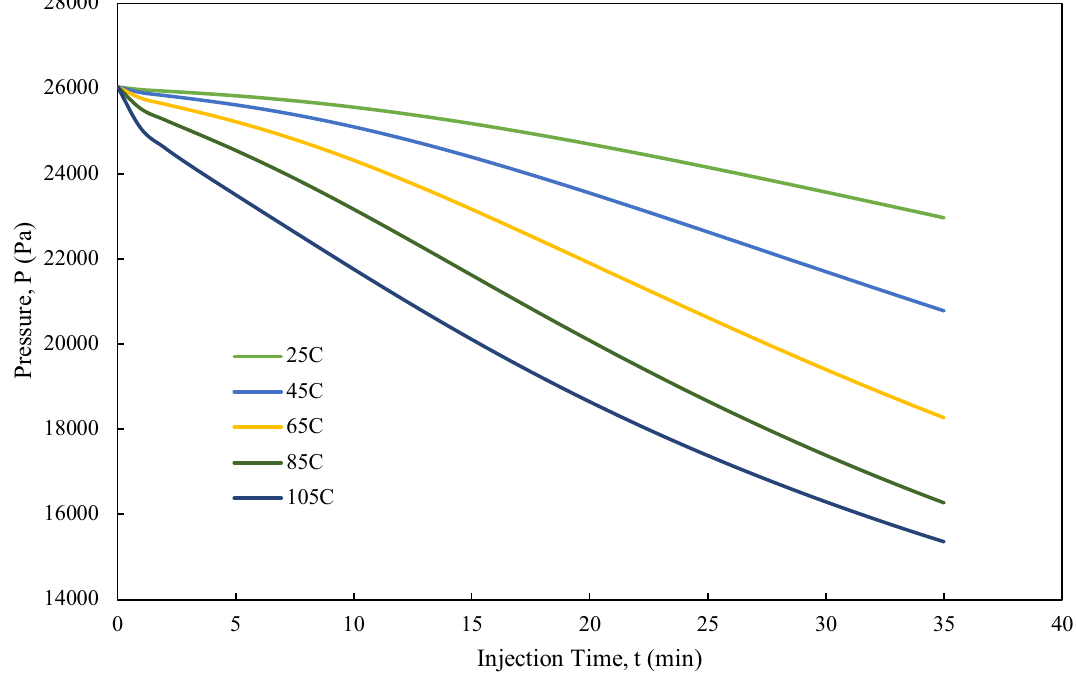
Fig. 10 The effect of temperatures on sandstone pressure drop after fluoroboric